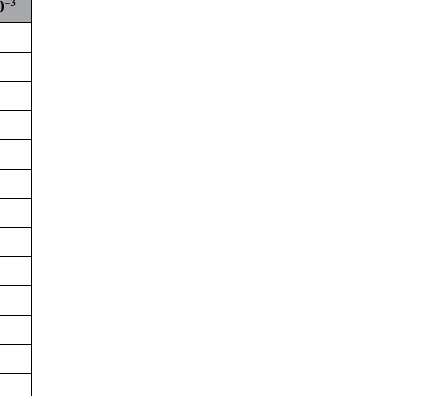
Table 2. Band gap energy, specific surface area and mesopore volume of CN materials.